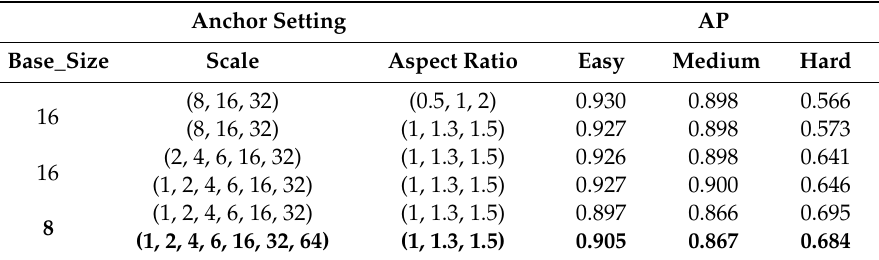
Table 2. Average precision (AP) comparison of di ff erent anchor sizes.